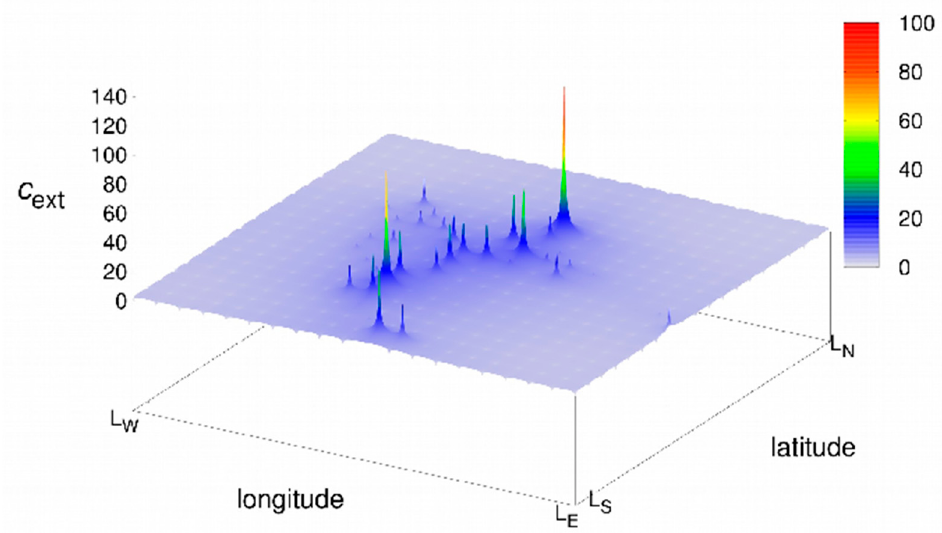
Figure 5. Distributions of rickshaw visits based on all accumulated data recorded on cloud server in our survey period. We eliminated two nodes since counts at these two points are excessive: node 11 (counts = 693) and node 231 (counts = 3293).